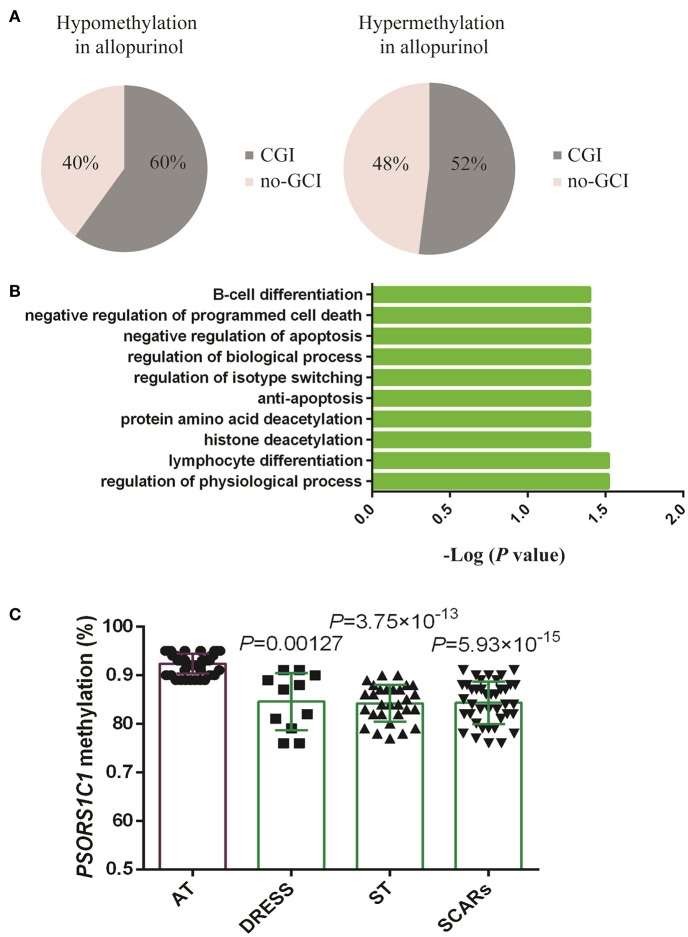
Analysis and validation of differentially methylated gene probes. (A) Proportions of gene probes associated with CpG islands (CGI) and no-CGI. (B) Gene Ontology (GO) biological processes annotation of differentially methylated genes using the GATHER Functional Annotation tool. (C) Validation of differentially methylated array site in gene PSORS1C1 in the replication cohort. Values were presented as mean ± SD. AT, allopurinol-tolerants; ST included SJS, SJS/TEN overlap and TEN; SCARs included DRESS, SJS, SJS/TEN overlap, and TEN. DRESS vs. AT P = 0.00127; ST vs. AT P = 3.75 × 10−13; SCARs vs. AT P = 5.93 × 10−15. Student's t-test analysis was applied for the comparison.